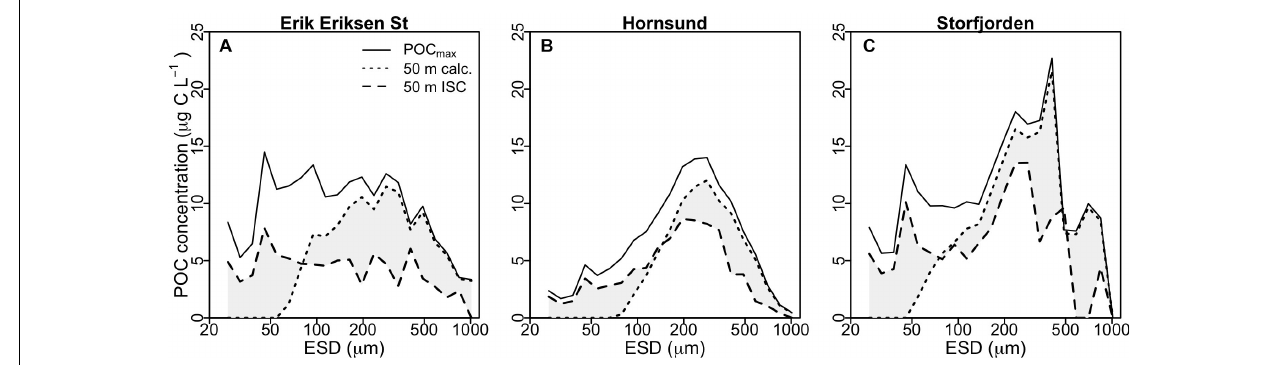
FIGURE 5 | Average POC distribution for different particle size classes at Erik Eriksen Strait (A) , Hornsund (B) , and Storfjorden (C) . Continuous lines show the POC max values from the ISC profiles, used as input in the calculations, dotted black lines show the calculated values at 50 m, based on microbial degradation and Calanus and Pseudocalanus aggregate feeding, and black dashed lines show the measured values at 50 m from the ISC profiles. Gray shaded area indicates differences between observed and calculated POC concentration at 50